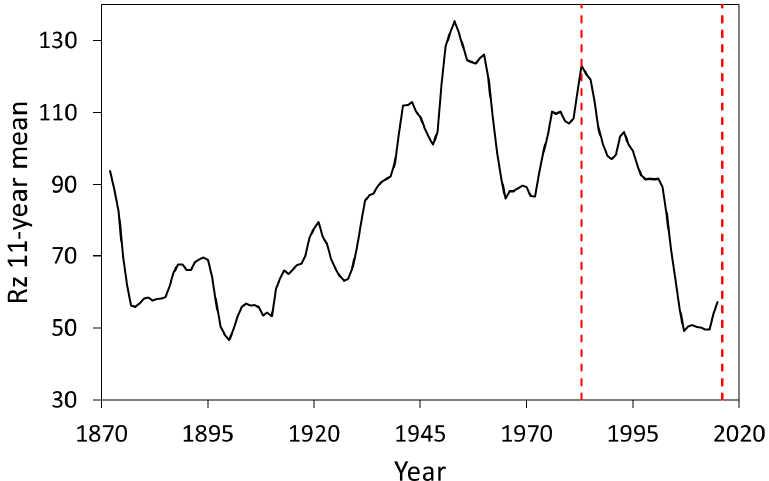
Figure 4. Sunspot number, Rz, 11-year running mean. Years 1983 and 2016 are indicated as vertical dashed red lines. Data obtained from WDC-SILSO, Royal Observatory of Belgium, Brussels (http://www.sidc.be/silso/datafiles, accessed on 17 April 2020).